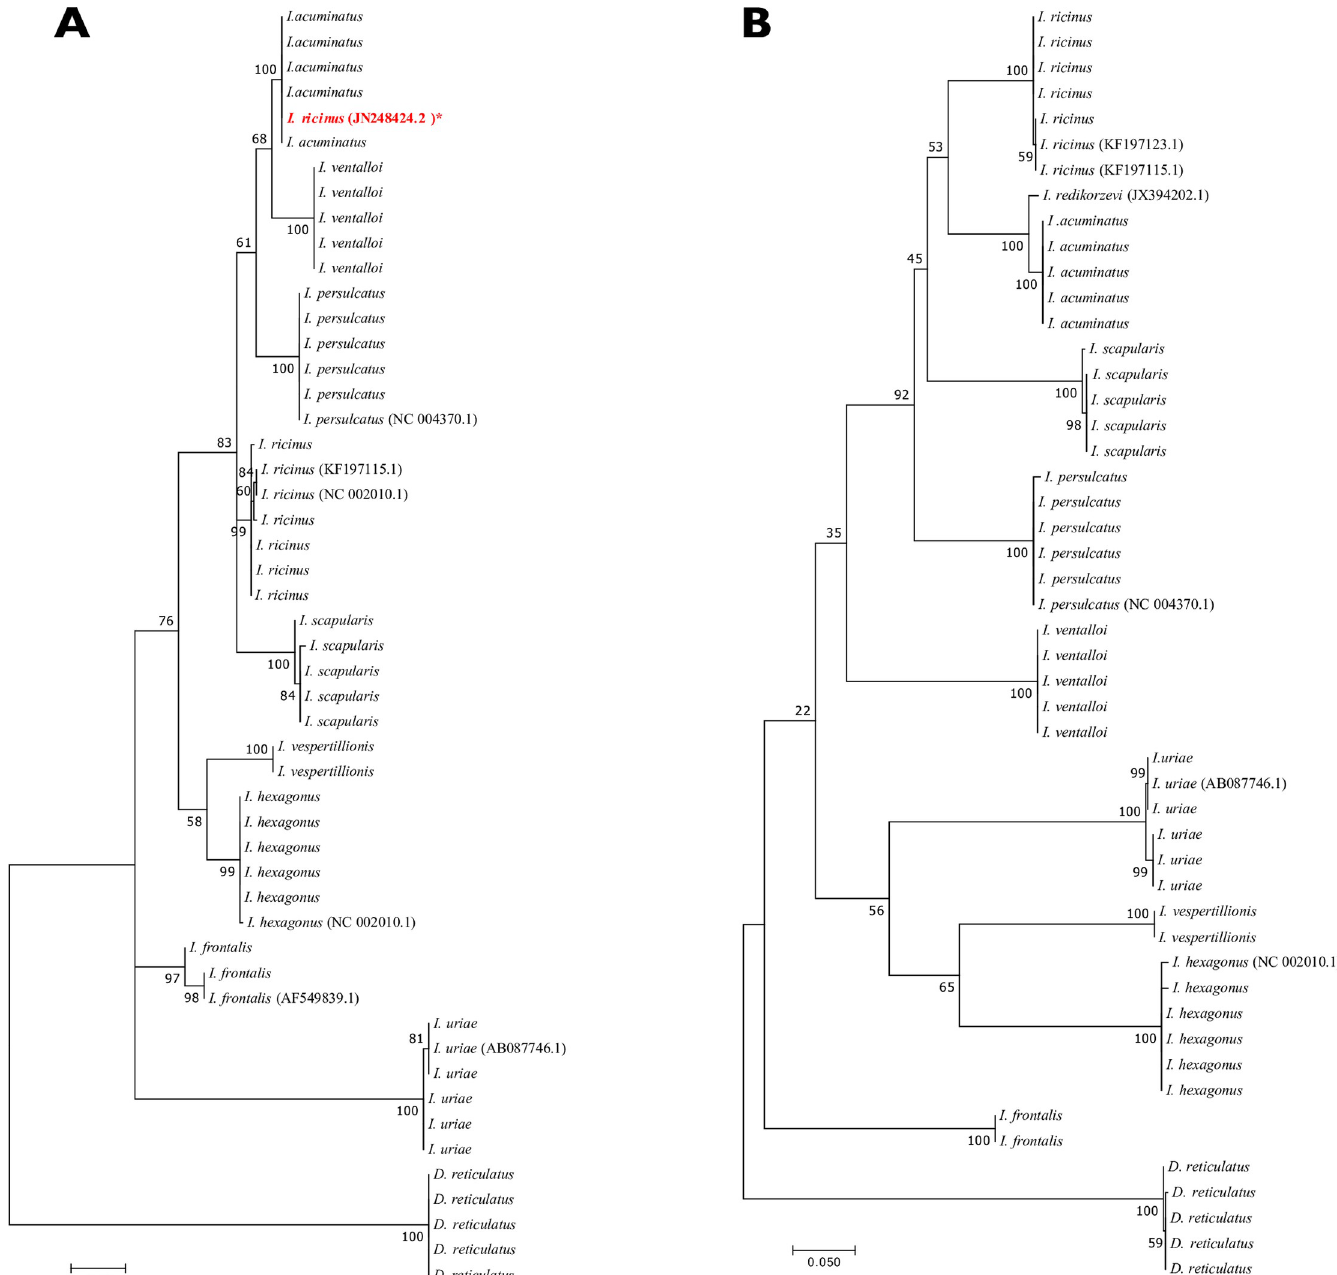
Fig 1. Unrooted maximum–likelihood trees based on the sequences of the 16s rDNA gene (A) and the COI gene (B) of the 44 specimens included in the database and GenBank sequences. � A GenBank sequence attributed to I . ricinus (Accession number JN248424.2) clustered with I . acuminatus on the 16s rDNA gene tree. https://doi.org/10.1371/journal.pone.0223735.g001 CCI matrix also revealed the correlation of MS spectra between specimens of the same spe- cies per body parts (0.57 ± 0.23 for legs: 0.57 ± 0.24 for half-idiosoma; S2 Fig). Conversely, lower CCI were obtained between Ixodes species and body parts (0. 13 ± 0.08 for legs and 0.14 ± 0.07 for half-idiosoma; S2 Fig) confirming the reproducibility and specificity of protein profiles according to tick species and body part.